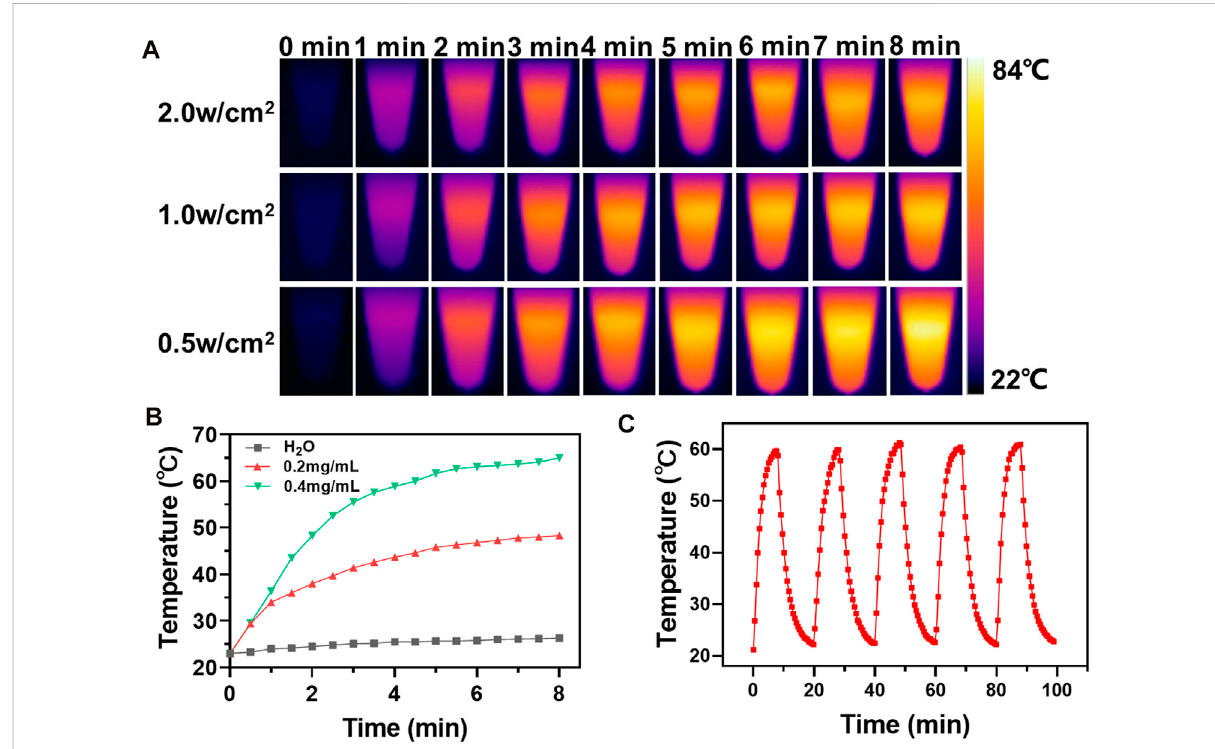
FIGURE 3 Photothermal effect of m-CuS-PEG NPs. (A) Photothermal performance of m-CuS-PEG (0.4 mg/ml) in aqueous solution under different NIR irradiation (808 nm, 0.5, 1.0, and 2.0 W/cm 2 ) at different time points; (B) The temperature changes at indicated time in vitro with m-CuS-PEG at different concentrations. (C) Photothermal cycle stability